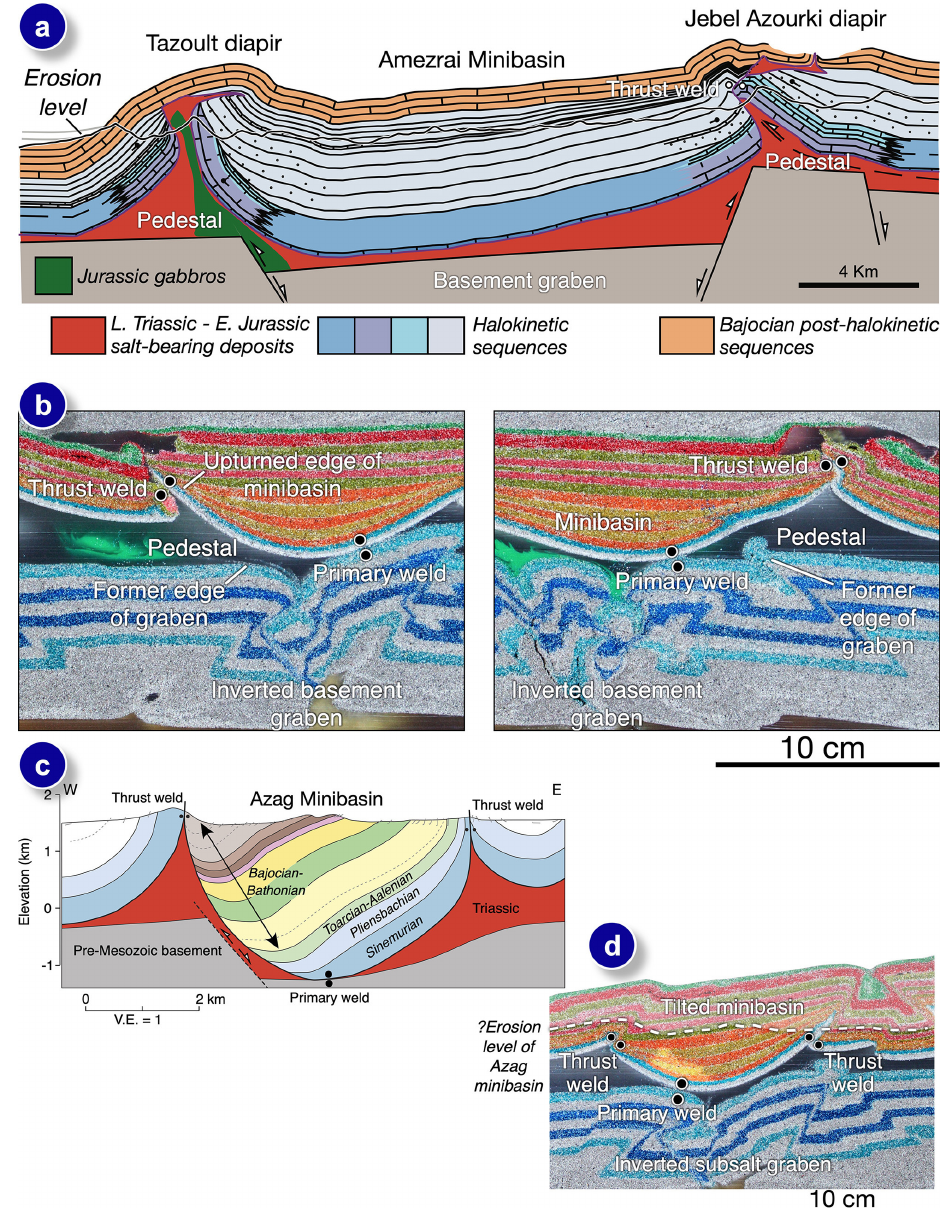
Figure 16. (a) Cross section through the Amezraï minibasin, Moroccan High Atlas. Note the uptilted minibasin margins, lack of internal deformation within the minibasin, and the complex flanking diapirs and thrust welds. Redrawn from Moragas et al. (2017). (b) Detailed views of minibasin margins and associated secondary thrust welds from Model 1. (c) E–W cross section through the Azag minibasin. Note the thrust welds and tilted nature of the minibasin. Redrawn from Teixell et al. (2017). (d) Detail of a section from Model 1 illustrating a tilted minibasin, primary weld on top of an inverted subsalt graben and secondary thrust welds on either side of the